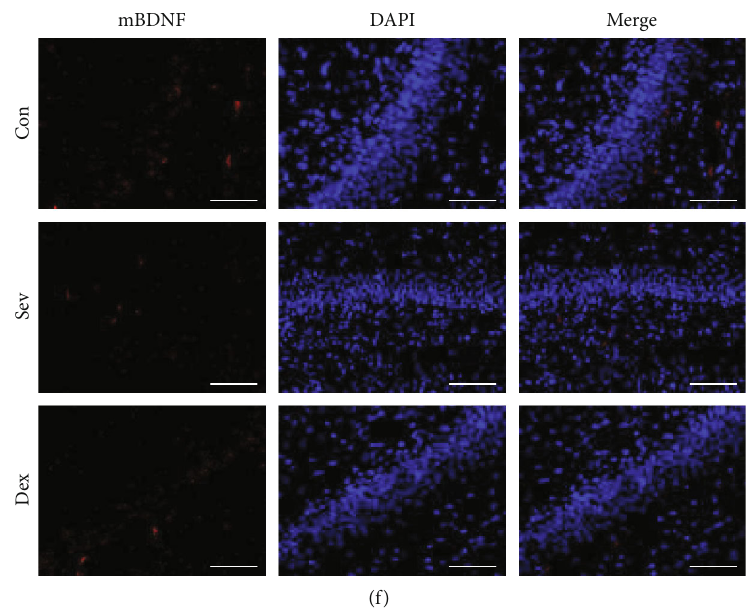
Figure 3: Dexmedetomidine could increase the level of mBDNF and relieve the inhibition of the BDNF-TrkB-CREB pathway caused by sevo fl urane in the hippocampus. (a) Western blot band. (b – e) Bar graph of Western blot. (f) Immuno fl uorescence of mBDNF ( scale bar = 50 μ m ). ∗ Compared with the control group, P < 0 : 05 ; # Compared with the Sev group, P < 0 : 05